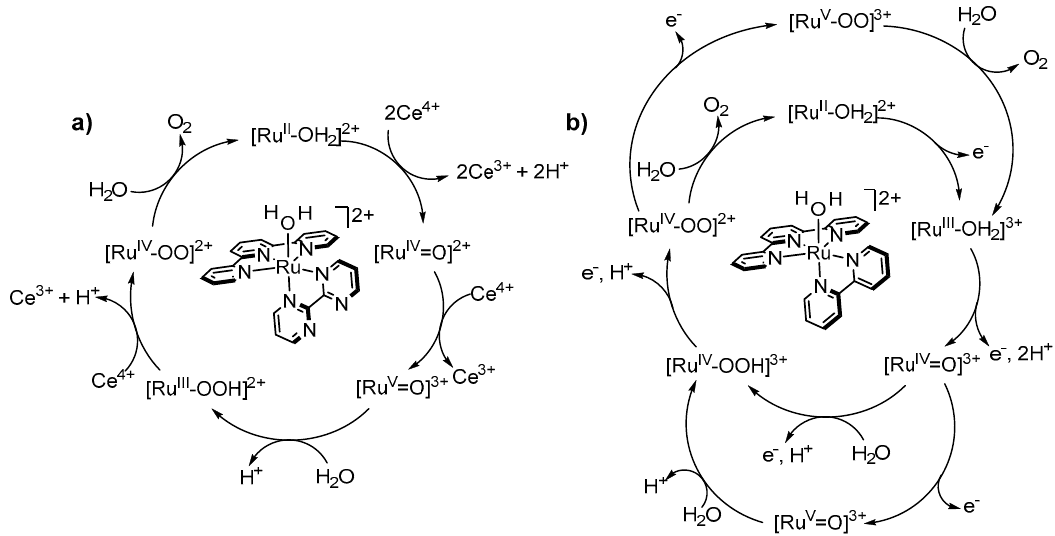
Figure 9. ( a ) Ce IV -mediated mechanism proposed by Meyer’s group of water oxidation by Ru(tpy)(bpy) complexes, ( b ) mechanism proposed by Pushkar.